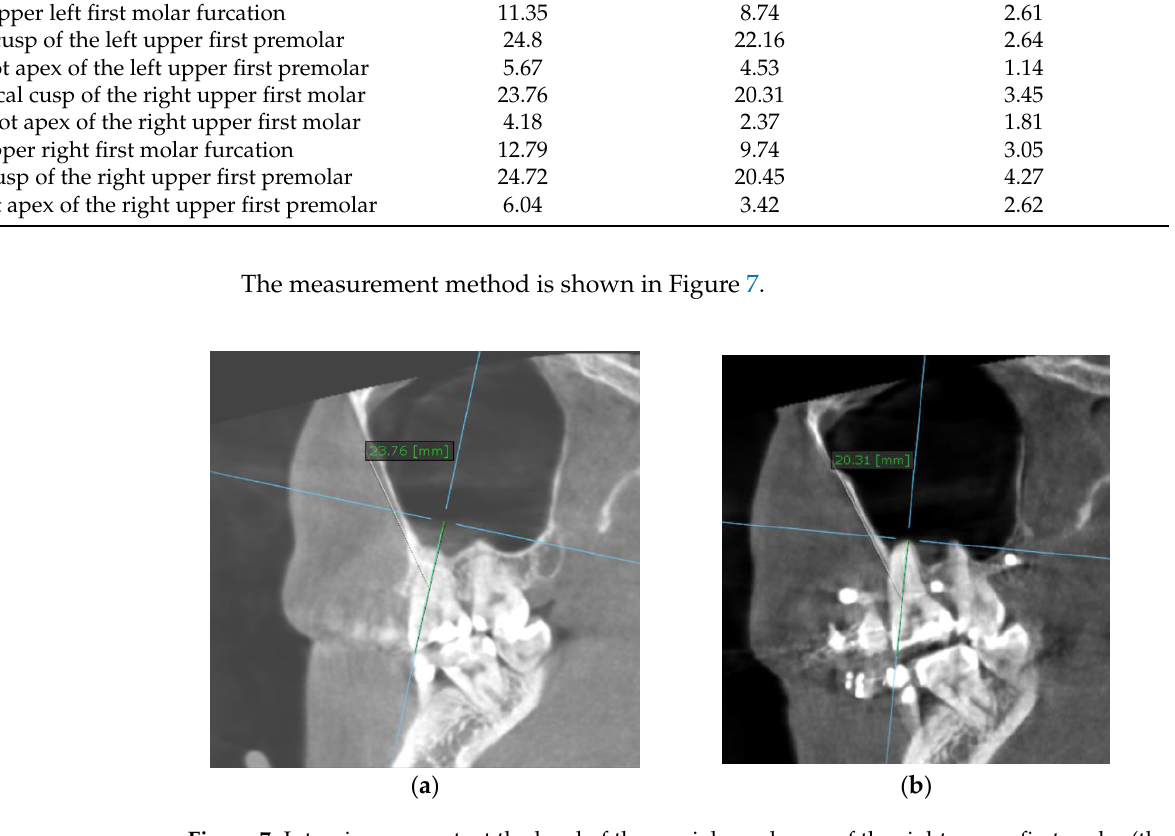
Figure 7. Intrusion amount, at the level of the mesiobuccal cusp of the right upper first molar (the distance between the cusp tip and CPP): ( a ) before intrusion: 23.76 mm; ( b ) after intrusion: 20.31 mm. Table 4. The CBCT measurements before and after intrusion at the level of upper first molar and upper first premolar.